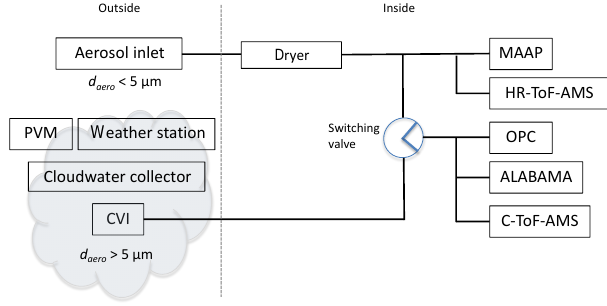
Figure 1. Measurement set-up and further operated instruments at the summit site Schmücke. Out-of-cloud aerosol was investigated by sampling through the aerosol inlet during cloud free periods while cloud residues were investigated by sampling through the CVI during cloud